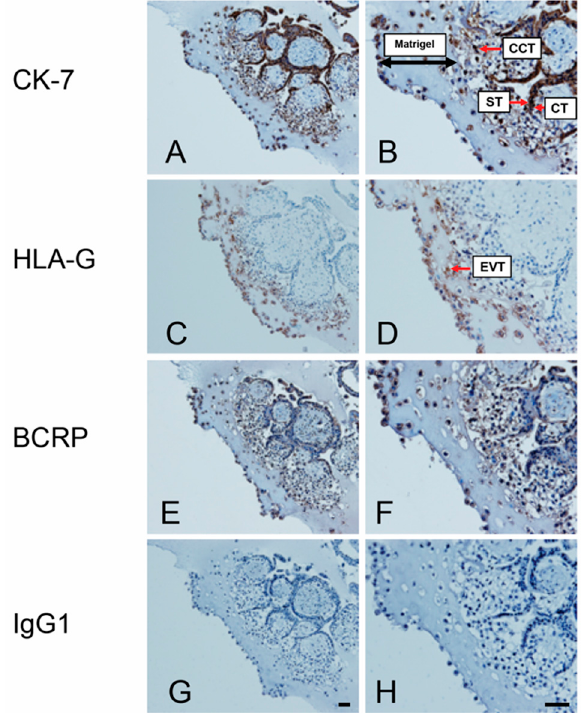
Figure 1. Breast cancer resistance protein (BCRP) is expressed in diverse trophoblast lineages including extravillous trophoblasts (EVT). Representative immunohistochemistry (IHC) images from tissue sections of first trimester human placental explants cultured on Matrigel (n = 6), showing: ( A , B ) cytokeratin 7 (CK7) expression (a trophoblast marker) in cytotrophoblast (CT), column cytotrophoblast (CCT), syncytiotrophoblast (ST), and extravillous trophoblast (EVT); ( C , D ) HLA-G expression in EVTs (EVT cell marker); ( E , F ) BCRP protein localization to CT, CCT, ST, and EVT; ( G , H ) non-immune mouse IgG1 control. Scalebars = 50 µm.